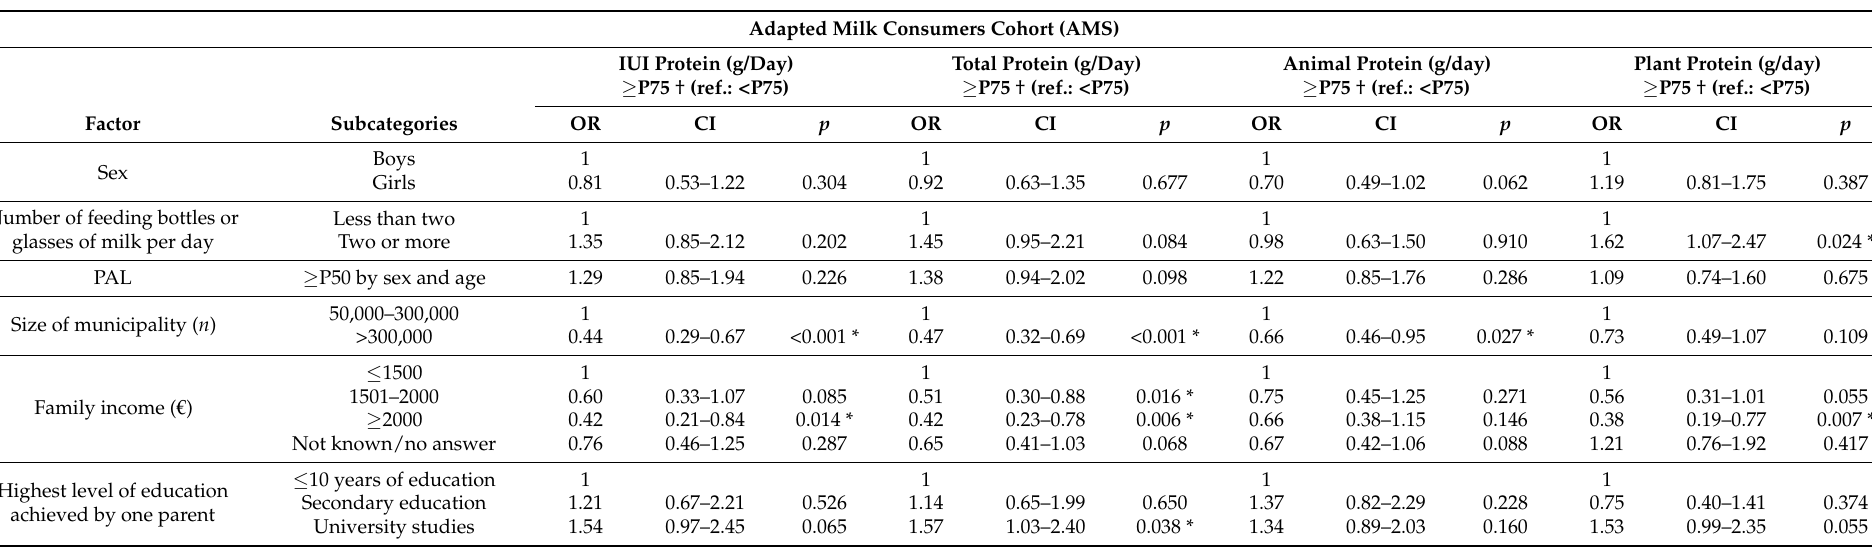
Table 8. Odds ratios and 95% confidence intervals for intake equal to or higher than the 75th percentile (P75) for total protein IUI, total protein, and animal and plant protein relative to family and personal factors in the adapted milk consumer cohort of the Nutritional Study in the Spanish Pediatric Population (EsNuPI) ( n =